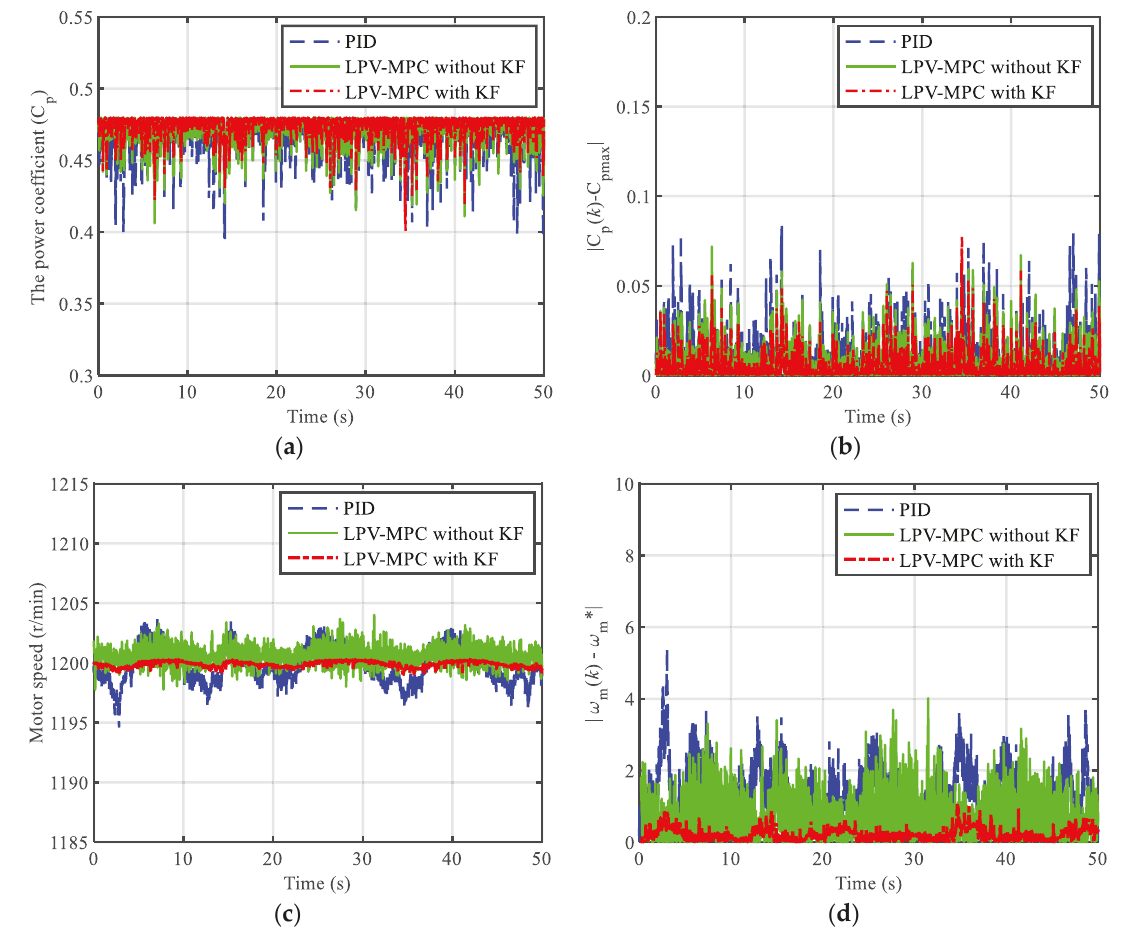
Figure 4. Comparison of power coefficients and variable motor speeds under different control methods in scenario 1: ( a ) power coefficient; ( b ) absolute error of power coefficient; ( c ) variable motor speeds; ( d ) absolute error of variable motor speeds.